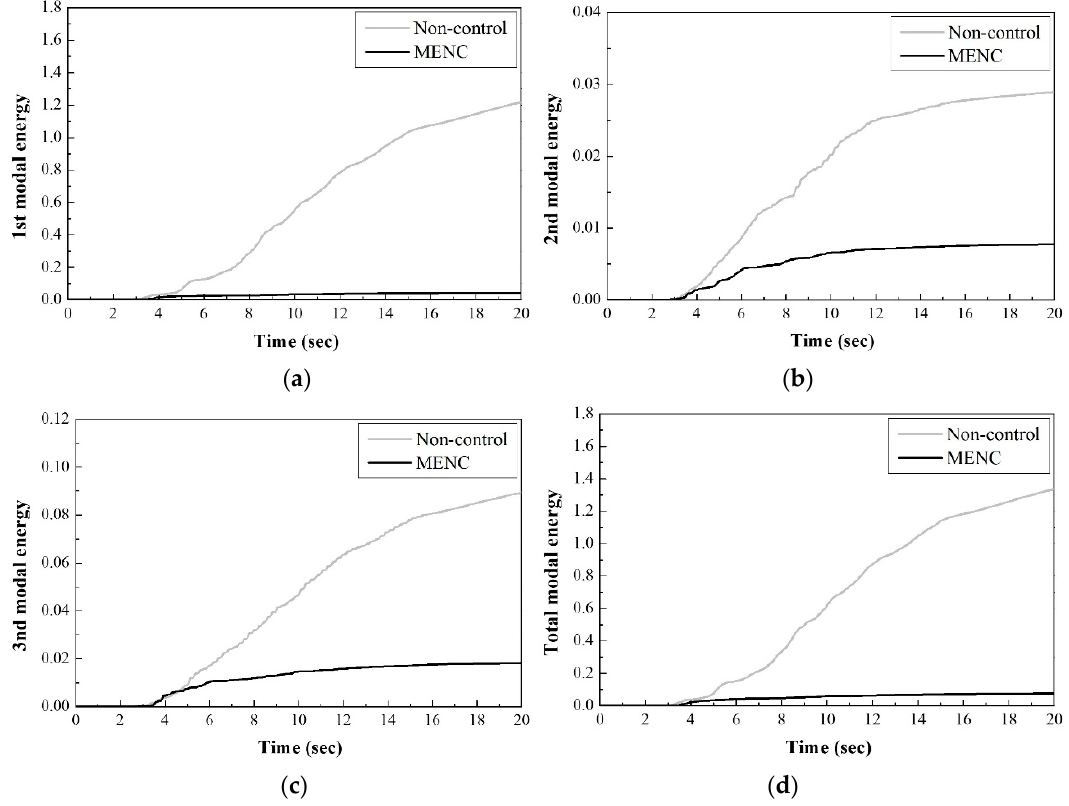
Figure 10. Comparison of modal energies in the control and non-control of the building structure under the California earthquake: ( a ) first modal energy; ( b ) second modal energy; ( c ) third modal energy; ( d ) total modal energy.